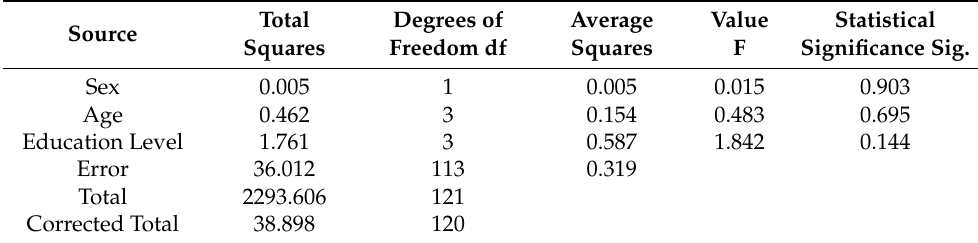
Table 6. Three-way ANOVA Triad Test to identify differences in volunteer skills due to gender, age, and educational